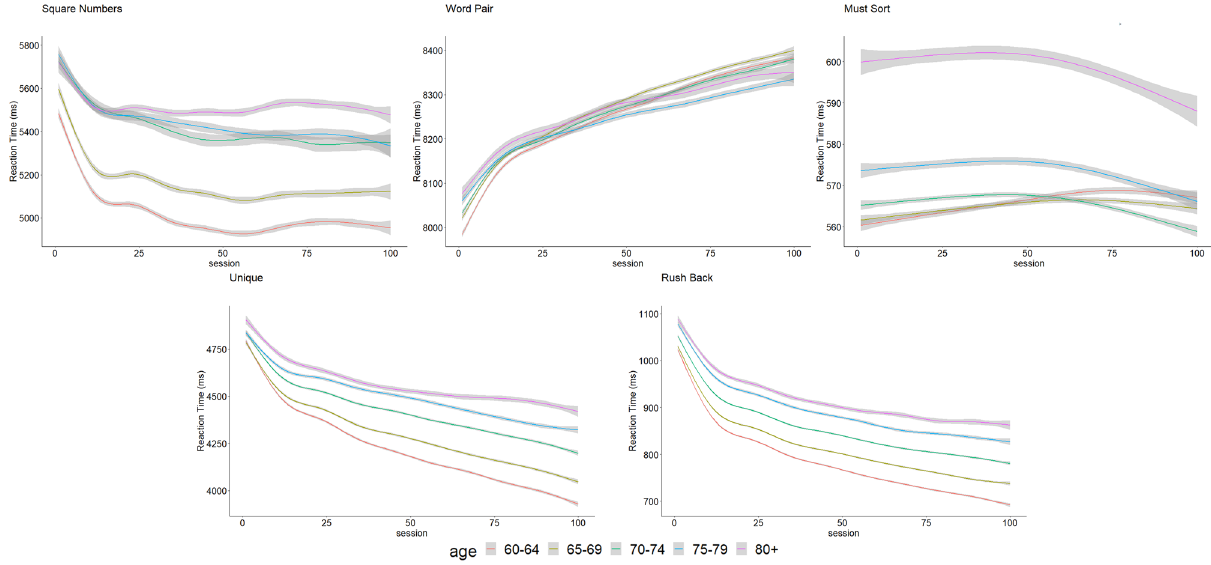
Figure 2. Time course of processing speed (measured as the reaction time) for the 5 different CMG over the 100 sessions, grey bands are the 95% CI.